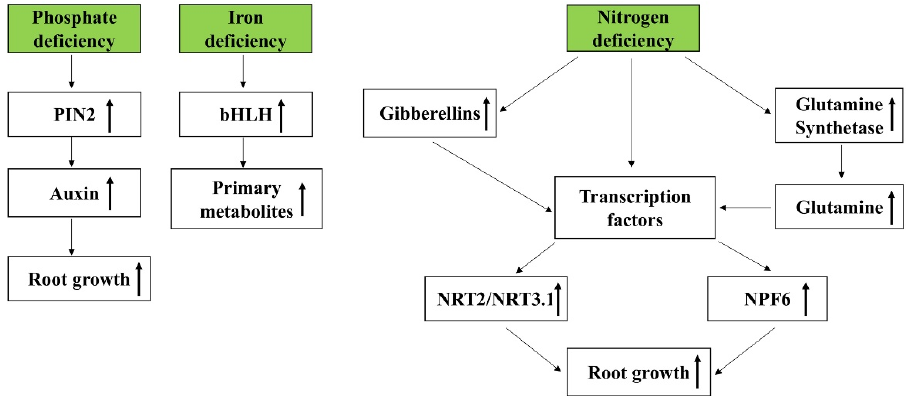
Figure 1. Schematic representation of molecular mechanisms involved in response to Pi, Fe and N deficiencies. PIN2, pin-formed 2, a component of the auxin efflux carrier; bHLH, basic helix–loop– helix transcription factors; NRT2, nitrate transporter 2; NRT3.1, nitrate transporter 3.1; NPF6, nitrate transporters of the nitrate transporter 1/peptide transporter class.